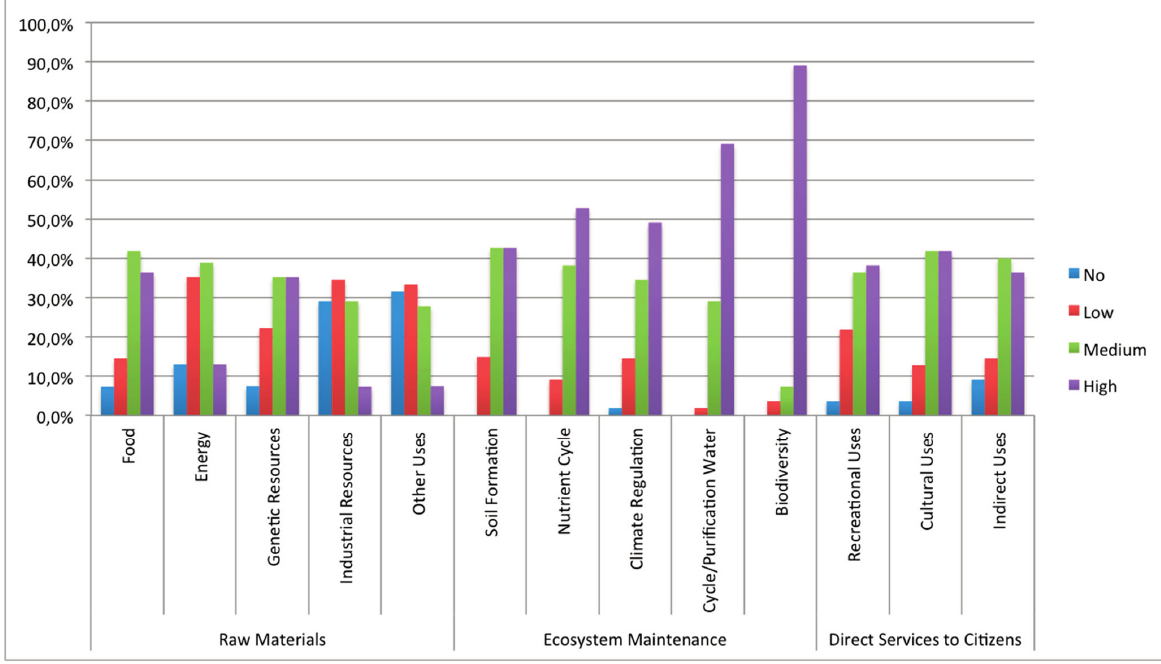
Figure 2. Percentage of decision makers, technical staff and other stakeholders by importance degree assigned to ecosystem services in the Natural Park